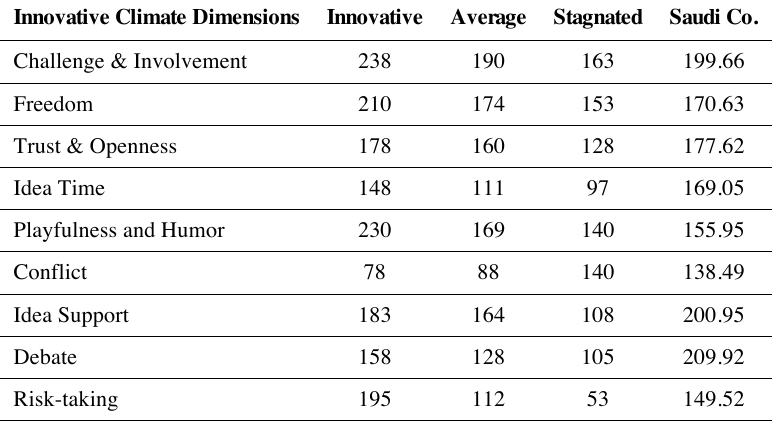
Table 4. Means of International Organizations Innovation Climate Dimensions and the Saudi